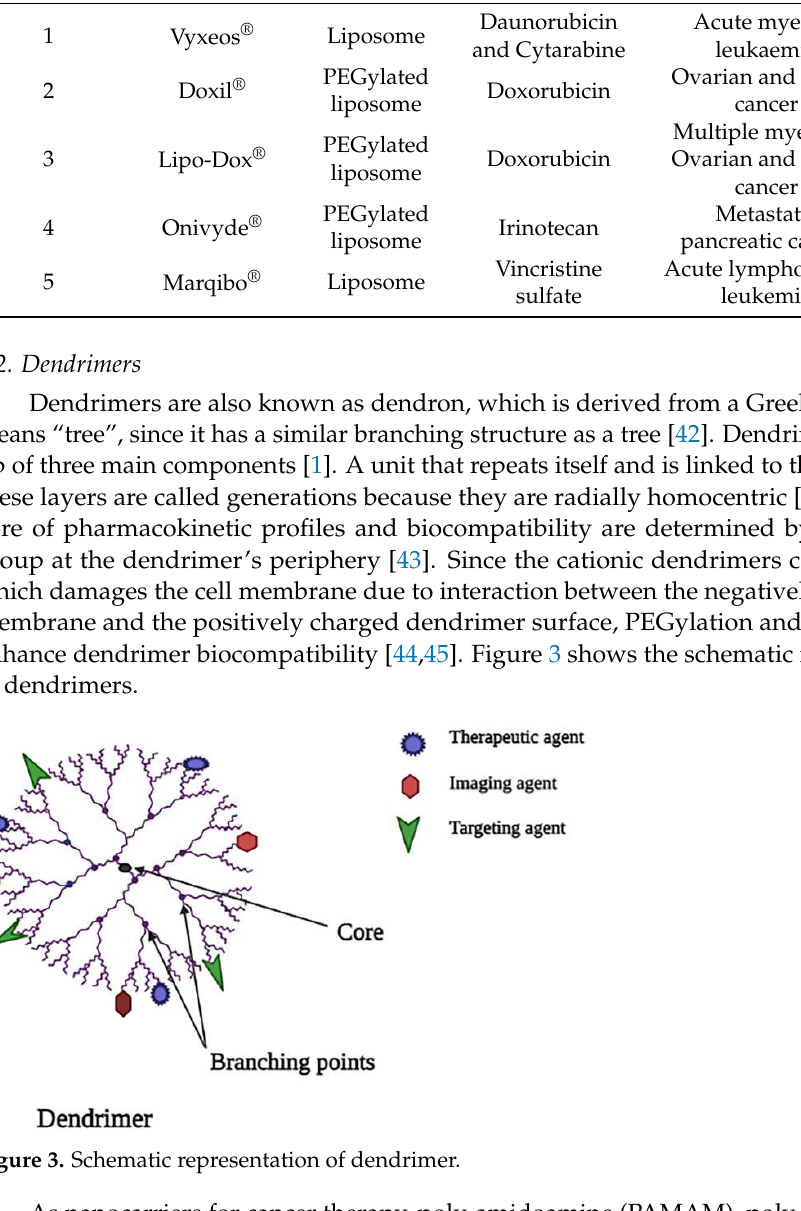
Table 1. Liposomal formulation approved by FDA for cancer therapy. Sr. No.